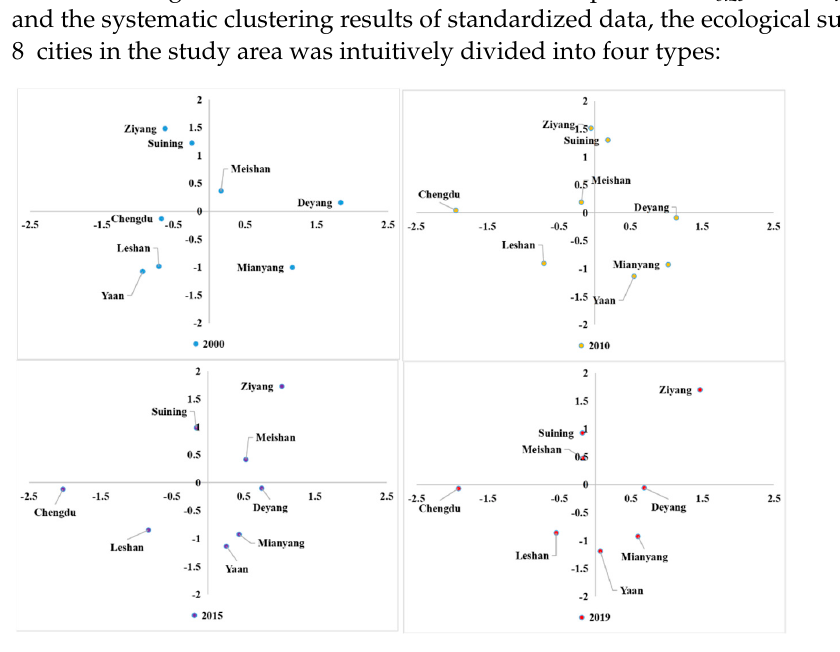
Figure 6. Quadrant scatter plots of the relationship between regional footprint depth and regional footprint size of each city.